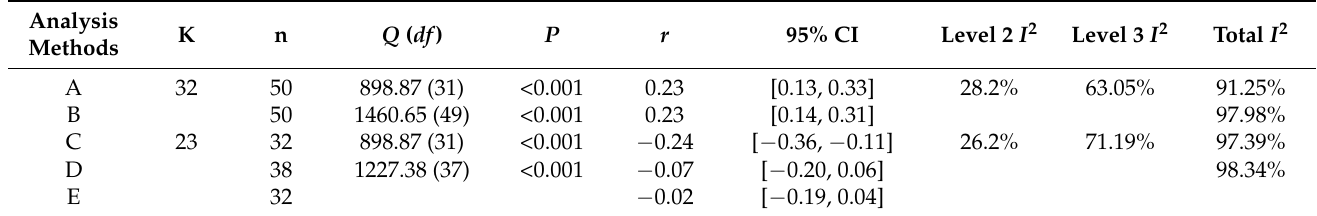
Table 1. The combined effect size of mindfulness and cognitive reappraisal and expressive suppression.